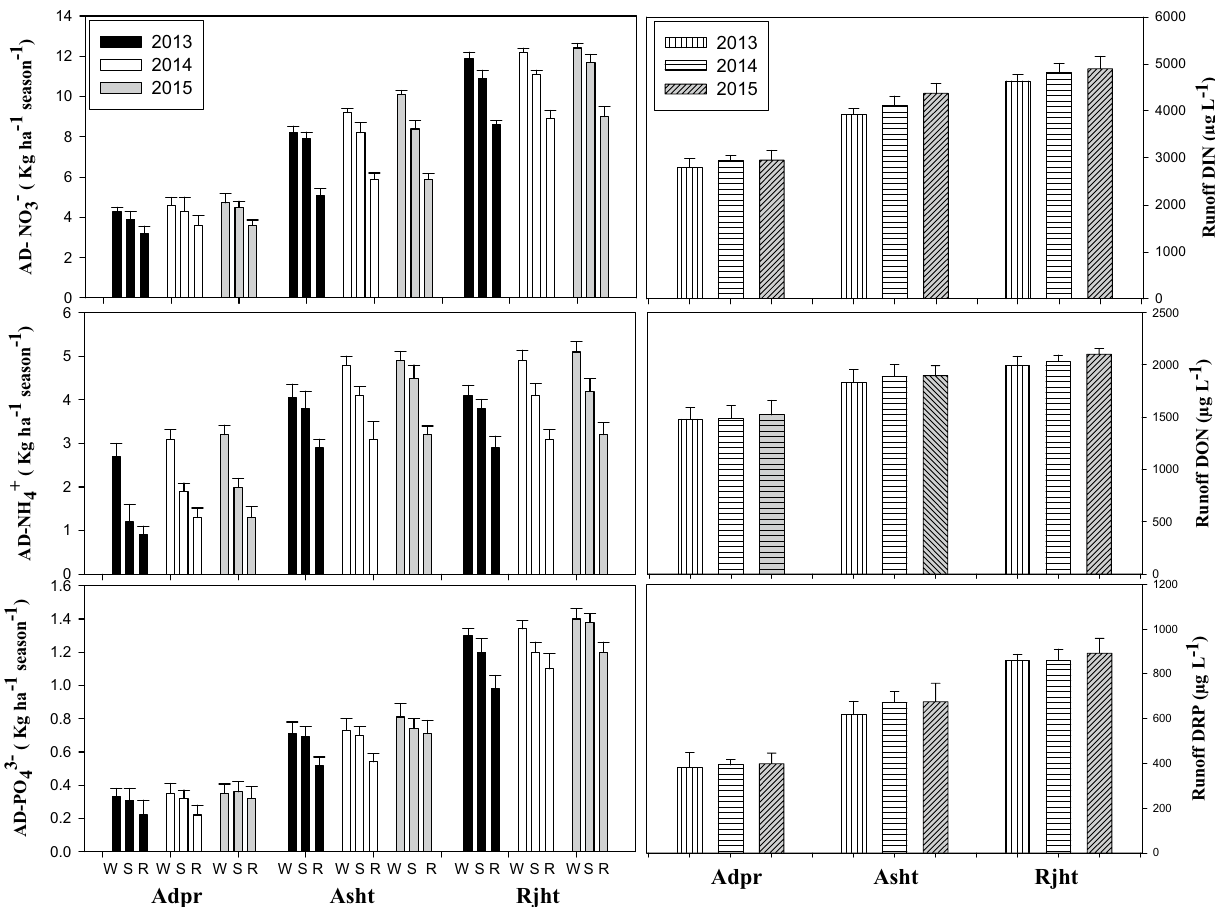
Fig. 2 Atmospheric deposition (AD) of NO 3− , NH 4+ and PO 43− and runoff concentrations of dissolved inorganic nitrogen (DIN), dis- solved organic nitrogen (DON) and dissolved reactive phosphorous